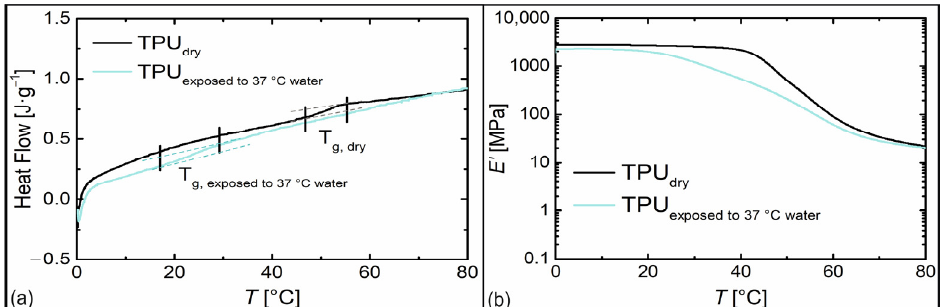
Figure 4. Thermal and thermomechanical properties of PPG-based TPU immediately after synthesis (black) compared to the same material stored in water for 3 days at 37 ◦ C (light blue). DSC ( a ); second heating with rates of 10 ◦ C · min − 1 ) and DMA ( b ); temperature dependence of storage modulus E ’ at a heating rate of 3 ◦ C · min − 1 ).